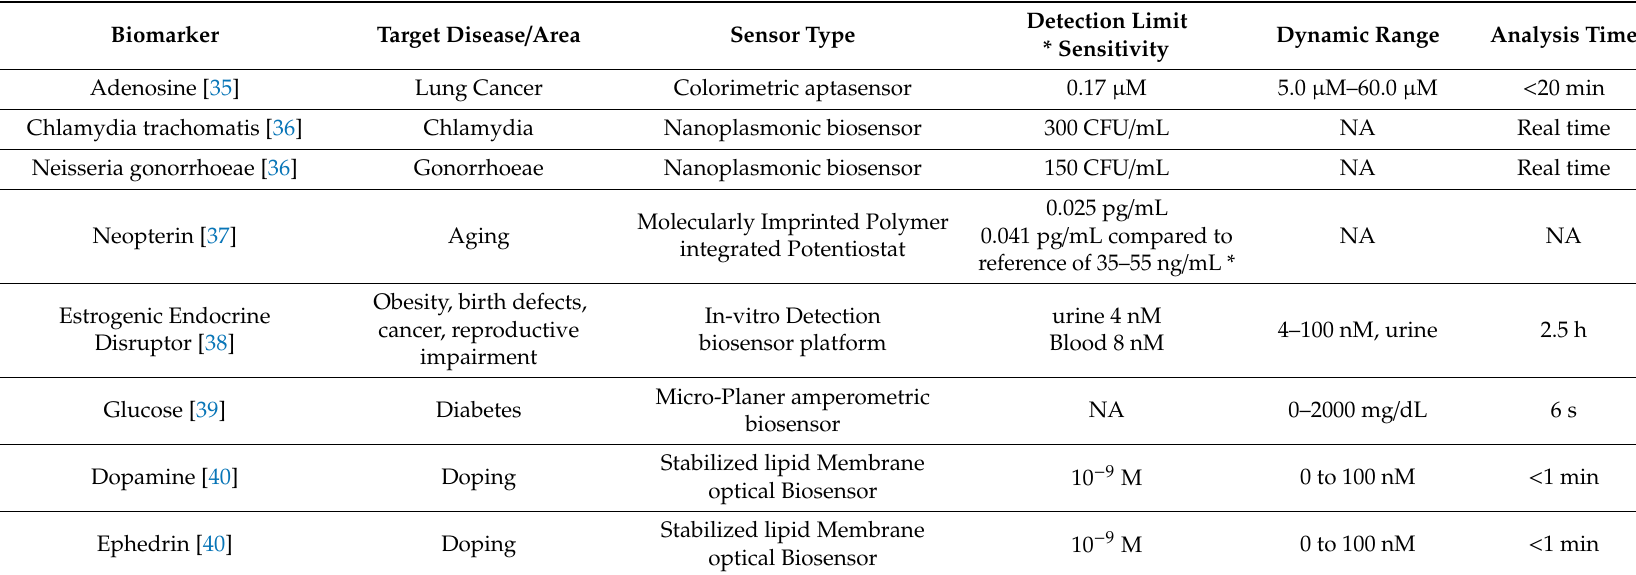
Table 3. Summary of Portable Biosensors for Urine Biomarker